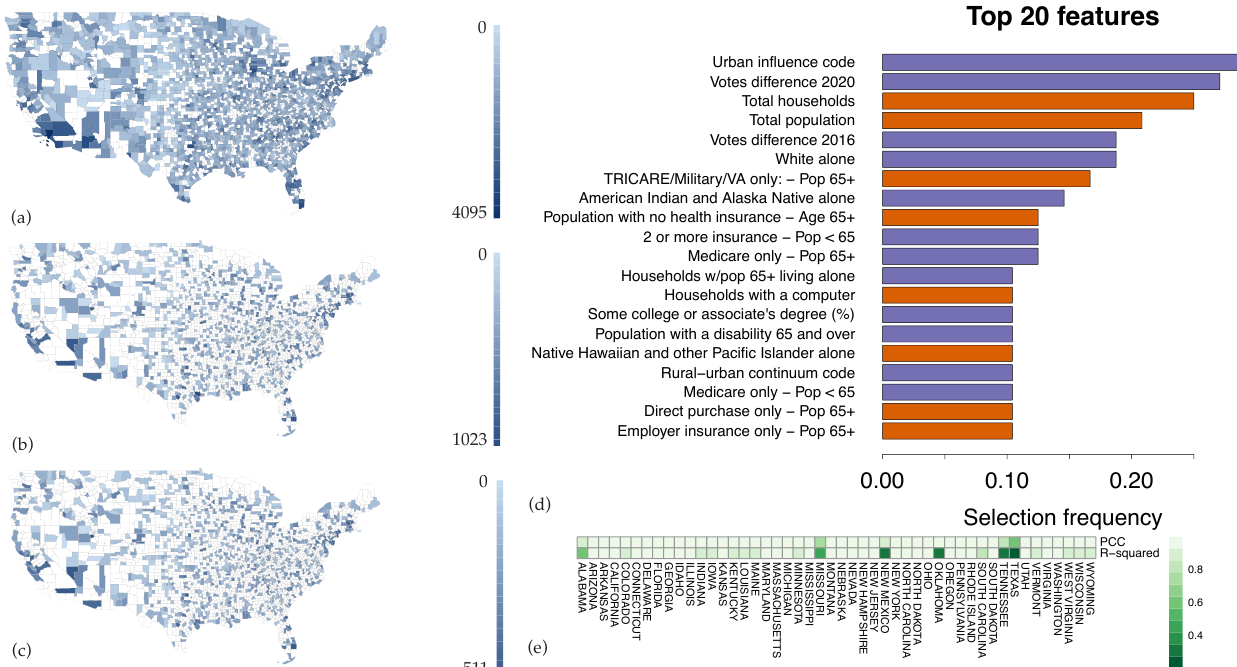
Figure 2. Spatial modeling of case dynamics during nationwide phase of pandemic. Blue shade indicates observed cases over first 30 days in counties used for model training ( a ) and testing (observed) ( b ), with predicted case counts in test counties shown in ( c ). Cases were aggregated over the time period after 11 September 2020 until 21 March 2021 in each county in the maps. ( d ) The most predictive top 20 features selected overall by the algorithm for the nationwide phase. Purple-colored features are negatively correlated with case counts, and the orange-colored features are positively correlated with case counts. ( e ) PCC and R 2 values of the predictive models on a state-by-state